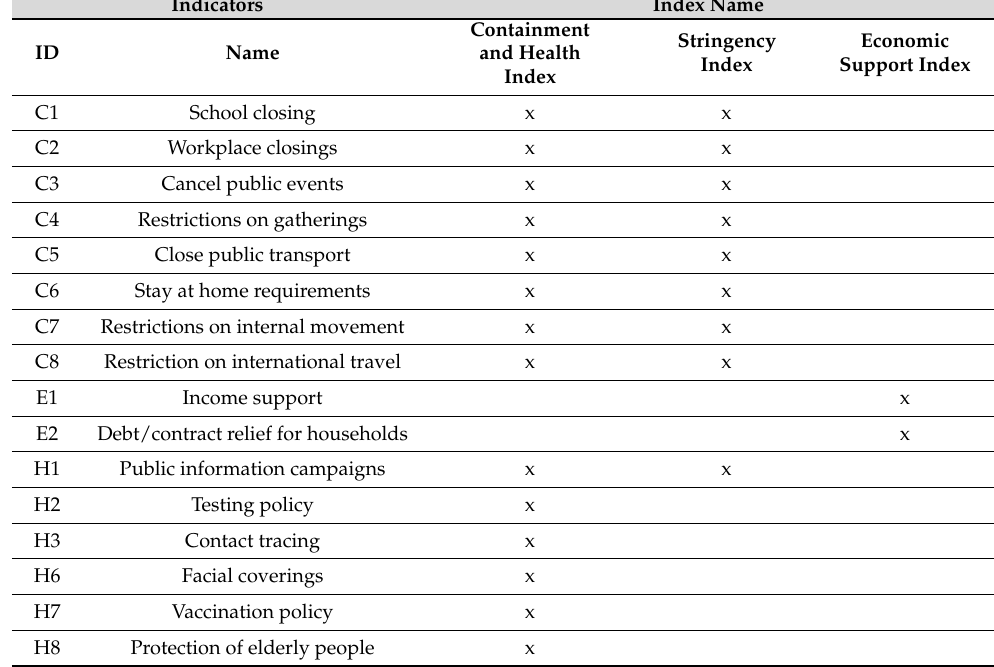
Table 1. Overview of OxCGRT